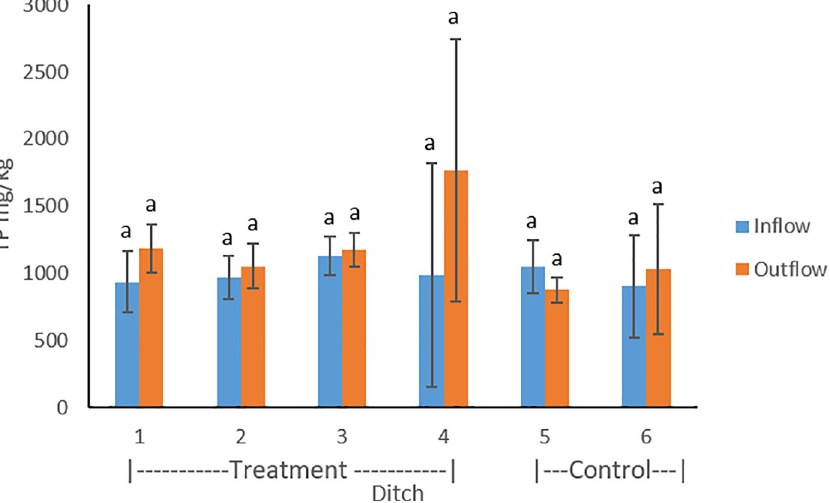
Fig 5. Sediment total phosphorus compared between inflow and outflow of the treatment (1–4) and control ditches (5–6). Error bars represent standard deviations throughout the three sampling